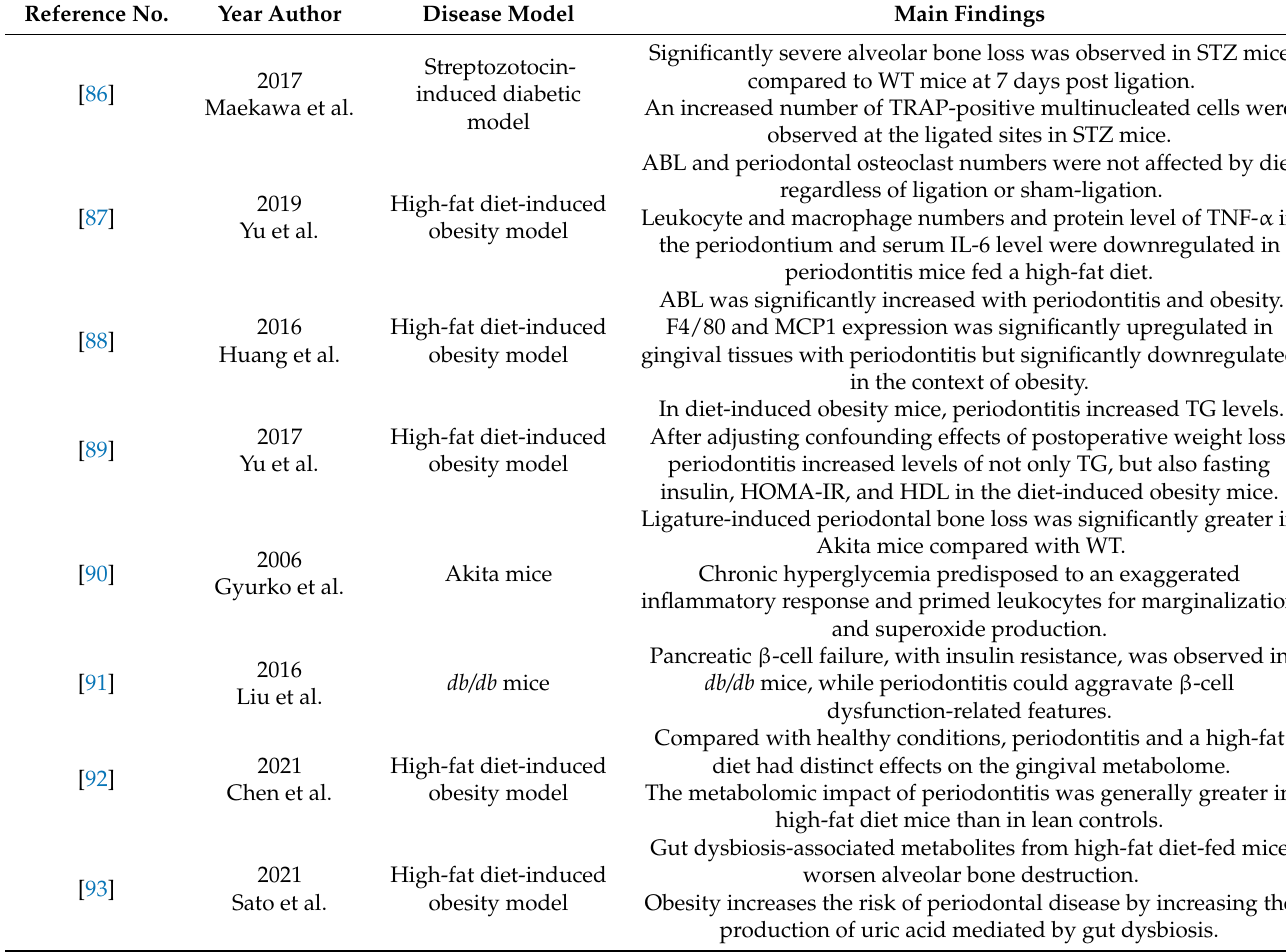
Table 2. Summary of the effect of ligature-induced periodontitis in disease model mice. Reference